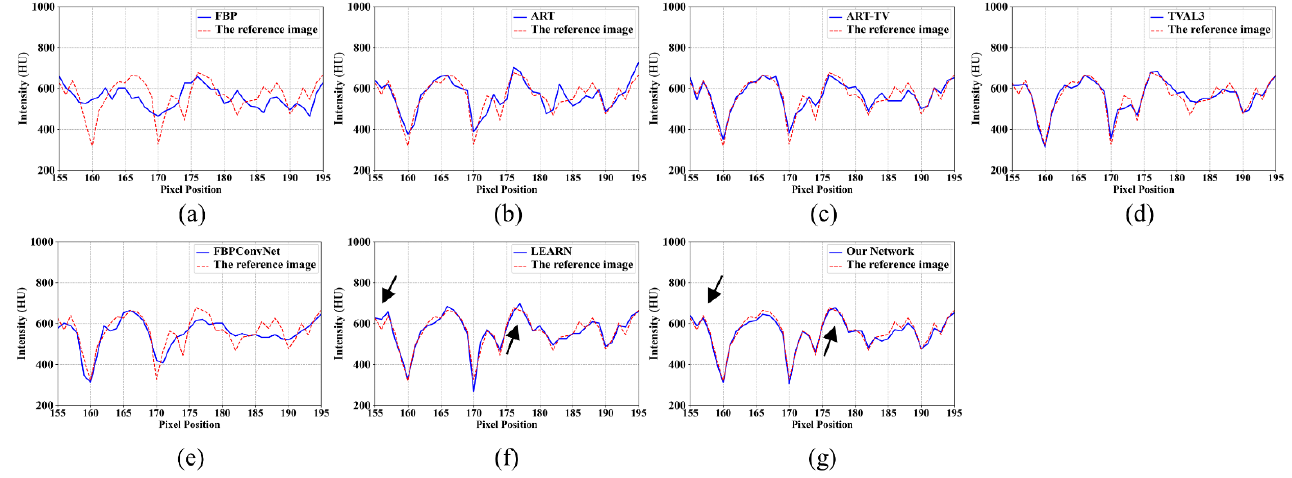
Figure 8. Horizontal profiles along the blue line shown in Figure 7a of the reference image versus